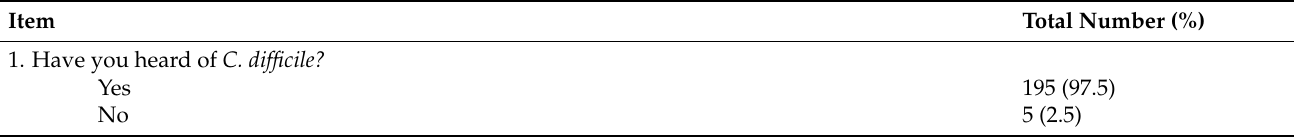
Table 2. Answer distribution to questions included in the Knowledge section (total = 200). Correct answers are underlined.